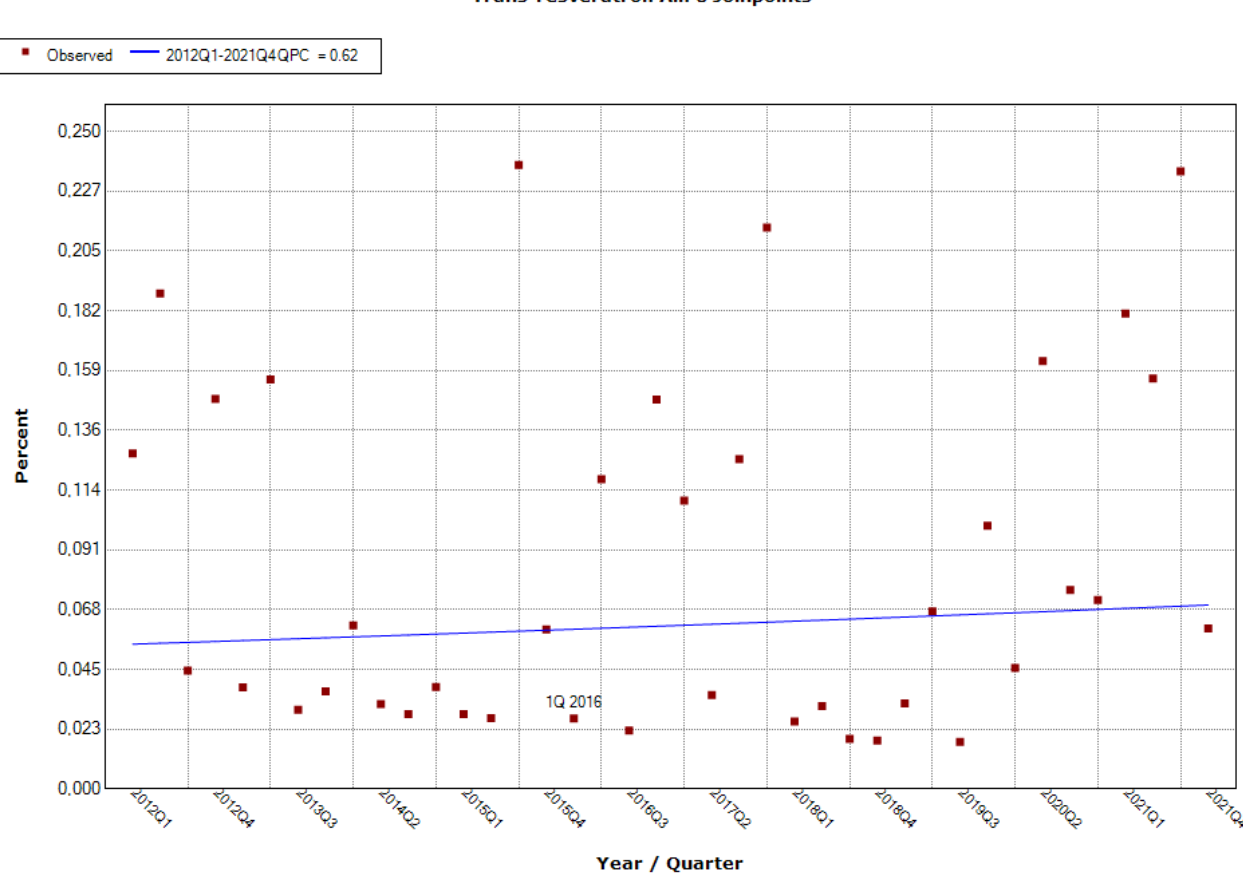
Figure A5. Percentage of products containing trans-resveratrol in individual quarters in the period from 2012 to 28 November 2021. Joinpoints mark trend turning points. The date above the observation indicates the moment of publication of the scientific opinion/resolution.